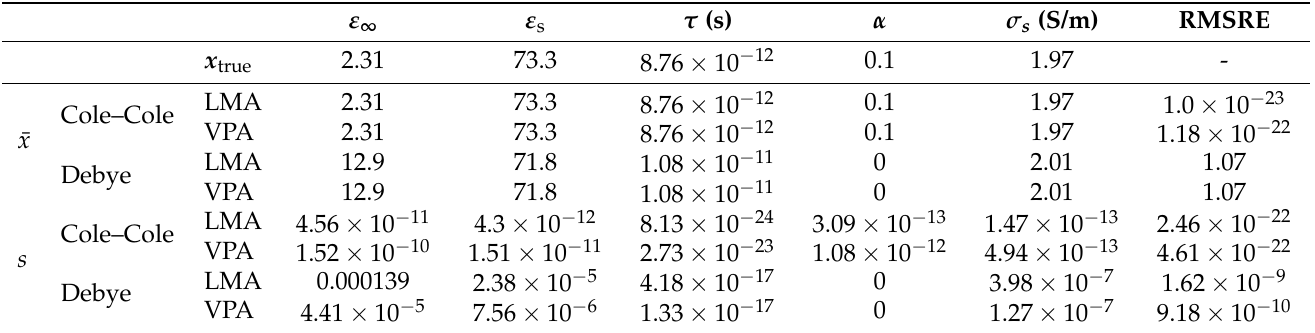
Table 4. Statistical diagnostics on fitting results. Set B of the initial points and 250 mg/dL glucose concentrations were considered.